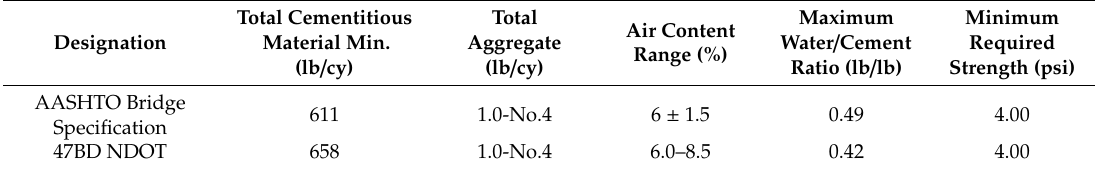
Table 1. Properties of the 47BD Mix Design used by the Nebraska Department of Transportation (NDOT)